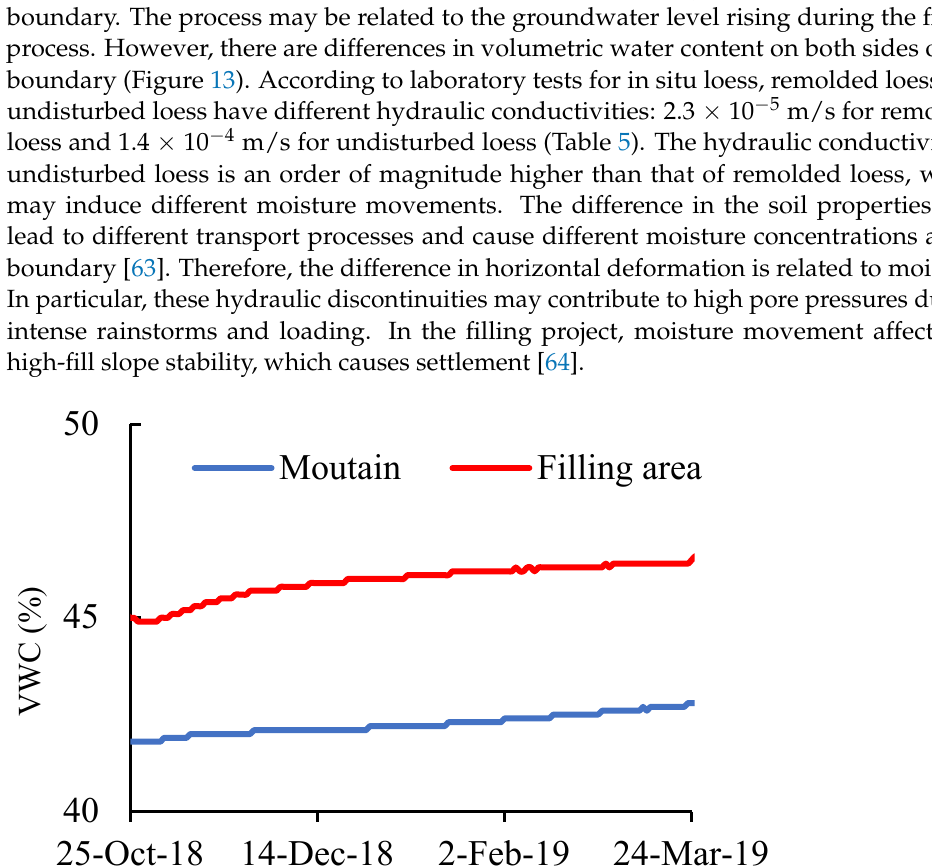
13 of 18 Figure 12. Compression curve shown by e ‐ log p plots (the orange line is undisturbed loess, and the blue line is remolded loess). In the filling project, due to the difference in compressibility, the internal deformation of loess produces different characteristics. The compression of undisturbed loess is small compared with that of remolded loess under low pressure. These differences cause the border to appear compressed. The filling body squeezes the adjacent areas. Therefore, dif ‐ ferent compression properties are one of the reasons that the boundary area becomes a